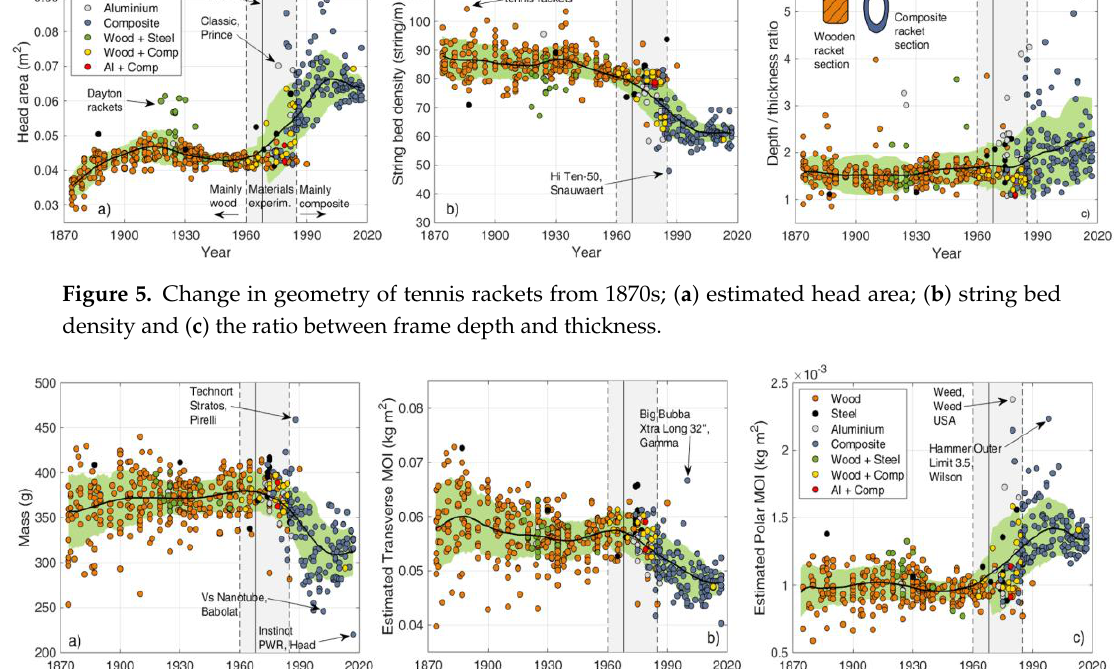
Figure 6. Change in inertial properties of tennis rackets from 1870s: ( a ) Mass; ( b ) estimated transverse MOI; and ( c ) polar MOI.